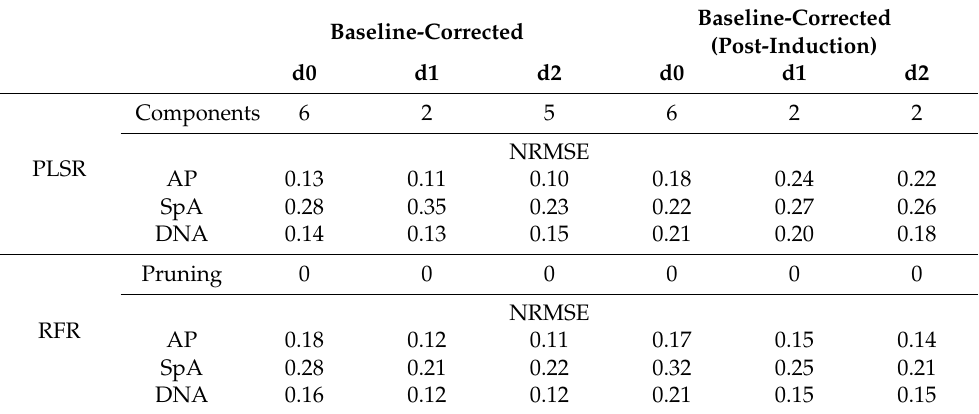
Table 2. Prediction errors for partial least square regression (PLSR) and random forest regression (RFR)